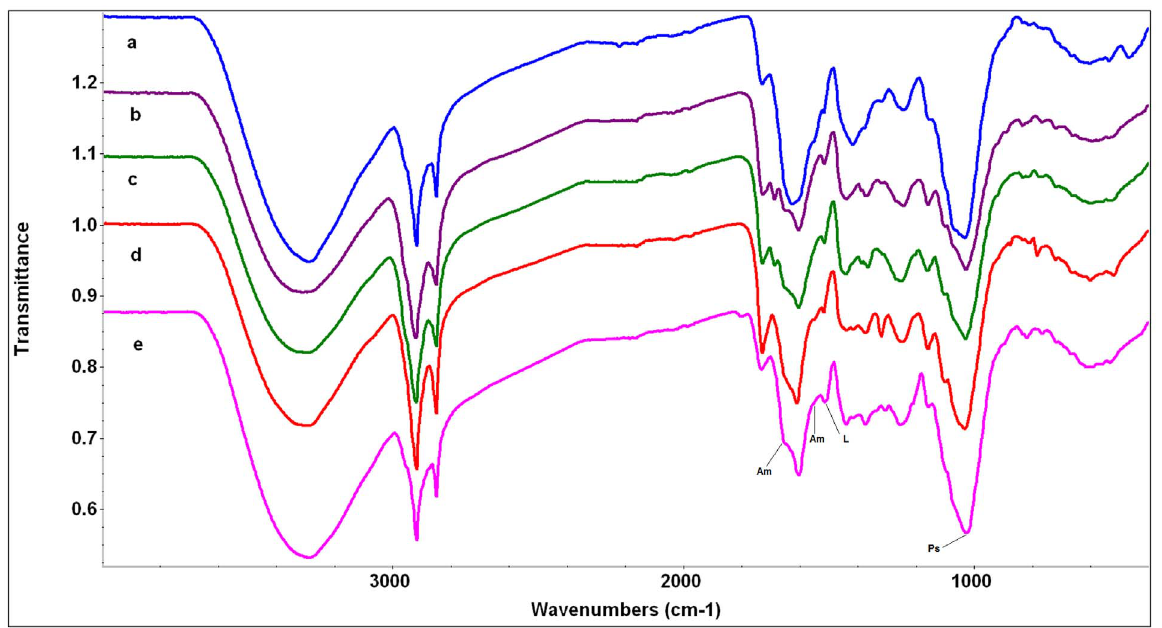
Figure 1. FTIR spectra of gypsovag species. The scale of the Y axis is offset for illustration purposes. a) Linum suffruticosum (blue), b) Rosmarinus officinalis (purple), c) Salvia lavandulifolia (green), d) Teucrium polium subsp. capitatum (red), e) Thymelaea tinctoria (pink). Abbreviations of compound peaks: Am: Amide, L: Lignin/Phenolic backbone, Ps: Polysaccharides.